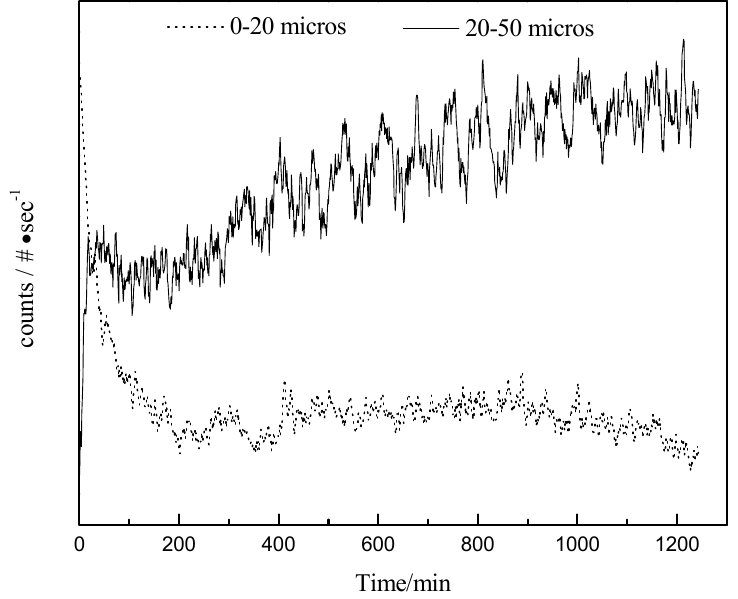
Figure 8. Development of chord length counts with time during Run